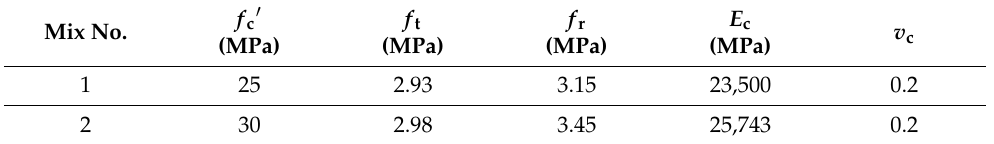
Table 2. Mechanical properties of the concrete [39].